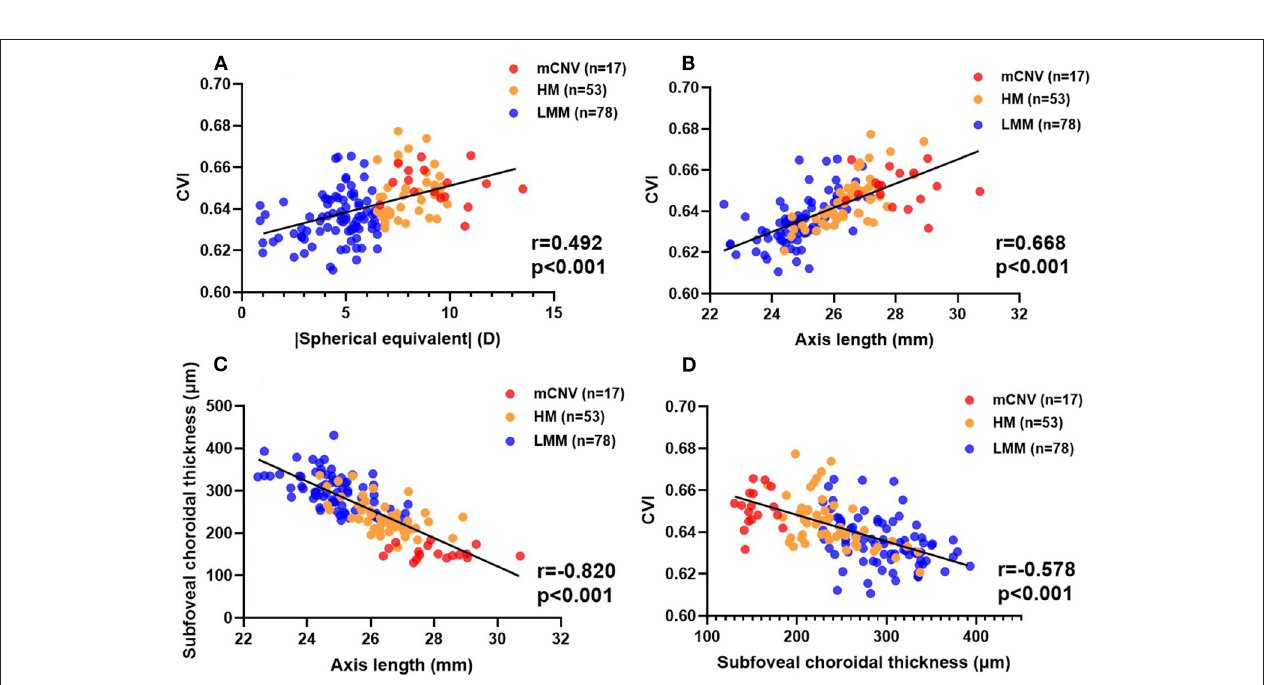
FIGURE 3 | Relationship between some ocular factors and OCT parameters of the choroid. Scatter plots showing the associations between CVI and |SE| (A) , CVI and AL (B) , SFCT and AL (C) , and CVI and SFCT (D) . LMM, low-to-moderate myopia; HM, high myopia; mCNV, myopic choroidal neovascularization; SFCT, subfoveal choroidal thickness; CVI, choroidal vascular